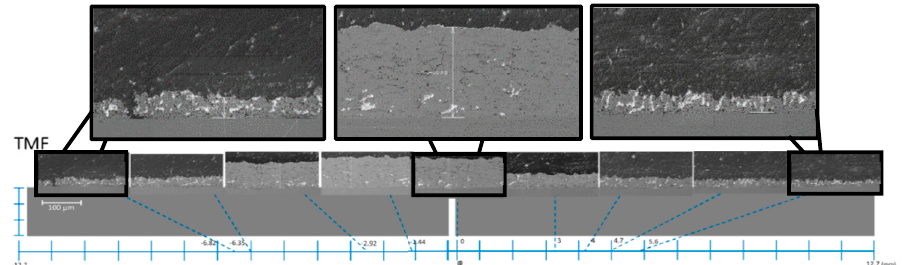
Figure 20. Cross-section images showing the structures developed in the flat as-machined sample (TMF).